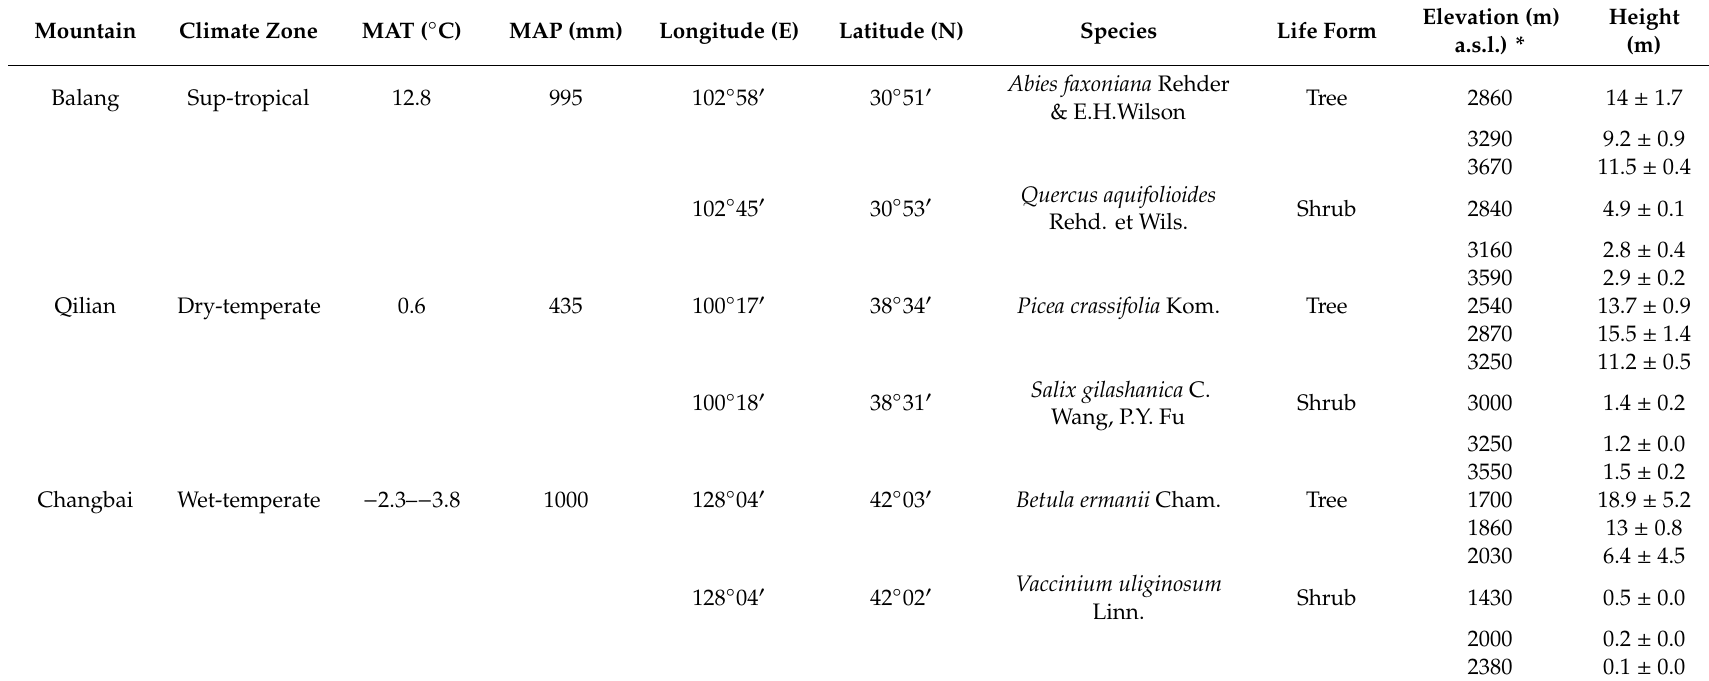
Table 1. The characteristics of sampling